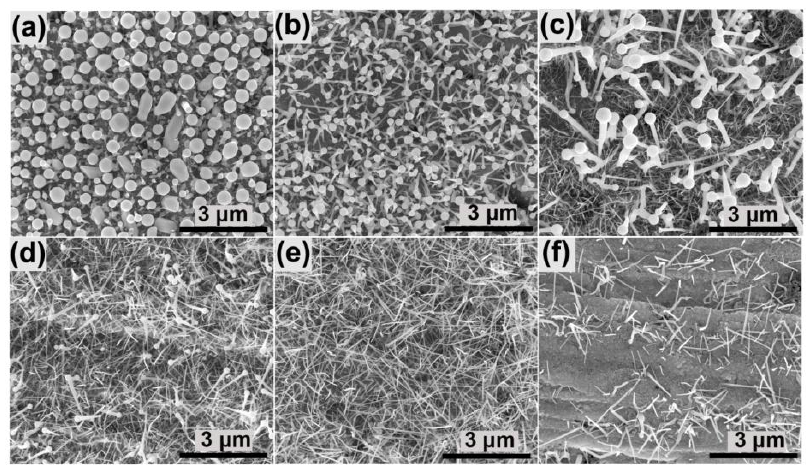
Figure 5. SEM images of the nanowires grown at ( a ) 420 °C, ( b ) 440 °C, ( c ) 460 °C, ( d ) 480 °C, ( e ) 500 °C and ( f ) 520 °C.